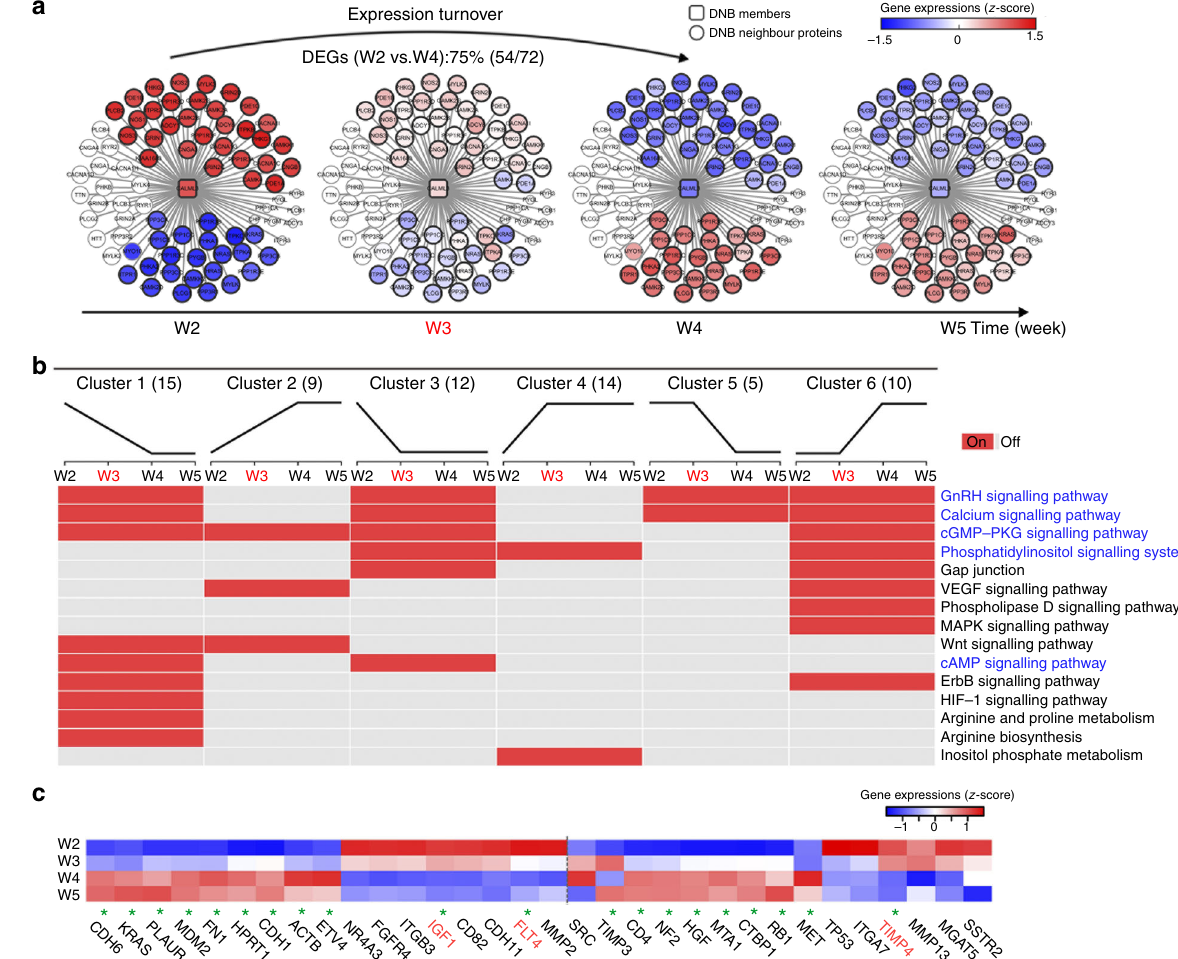
Fig. 5 Dynamics of CALML3-affected genes in terms of expression and function during the progression of pulmonary metastasis. a These series of networks demonstrated the dynamic changes in CALML3 and its neighbouring genes in terms of expression during metastasis. Expression of CALML3 and its 53 neighbouring DEGs changed signi fi cantly (or inversed) from low (or high) at week 2 to high (or low) at weeks 4 and 5 (i.e., the expression of those genes inversed before and after the critical period, at week 3). Here, expression turnover means that the expression of the genes changed signi fi cantly from low (high) to high (low) before and after the tipping point of metastasis (week 3). b A heatmap showed dynamic activity of the related KEGG pathways that involved CALML3 and its neighbouring DEGs in different dynamic patterns. c A heatmap illustrated the coexpression of CALML3 and typical cancer- related genes. The 17 genes listed on the left of the broken line were also DEGs in the transcriptomic data; 20 genes labelled by a green star had the same relationships with CALML3 by analysis of both the whole-genome expression pro fi ling and the RT 2 Pro fi ler PCR arrays. Genes in red showed positive coexpression with CALML3, whereas genes in black showed negative coexpression with